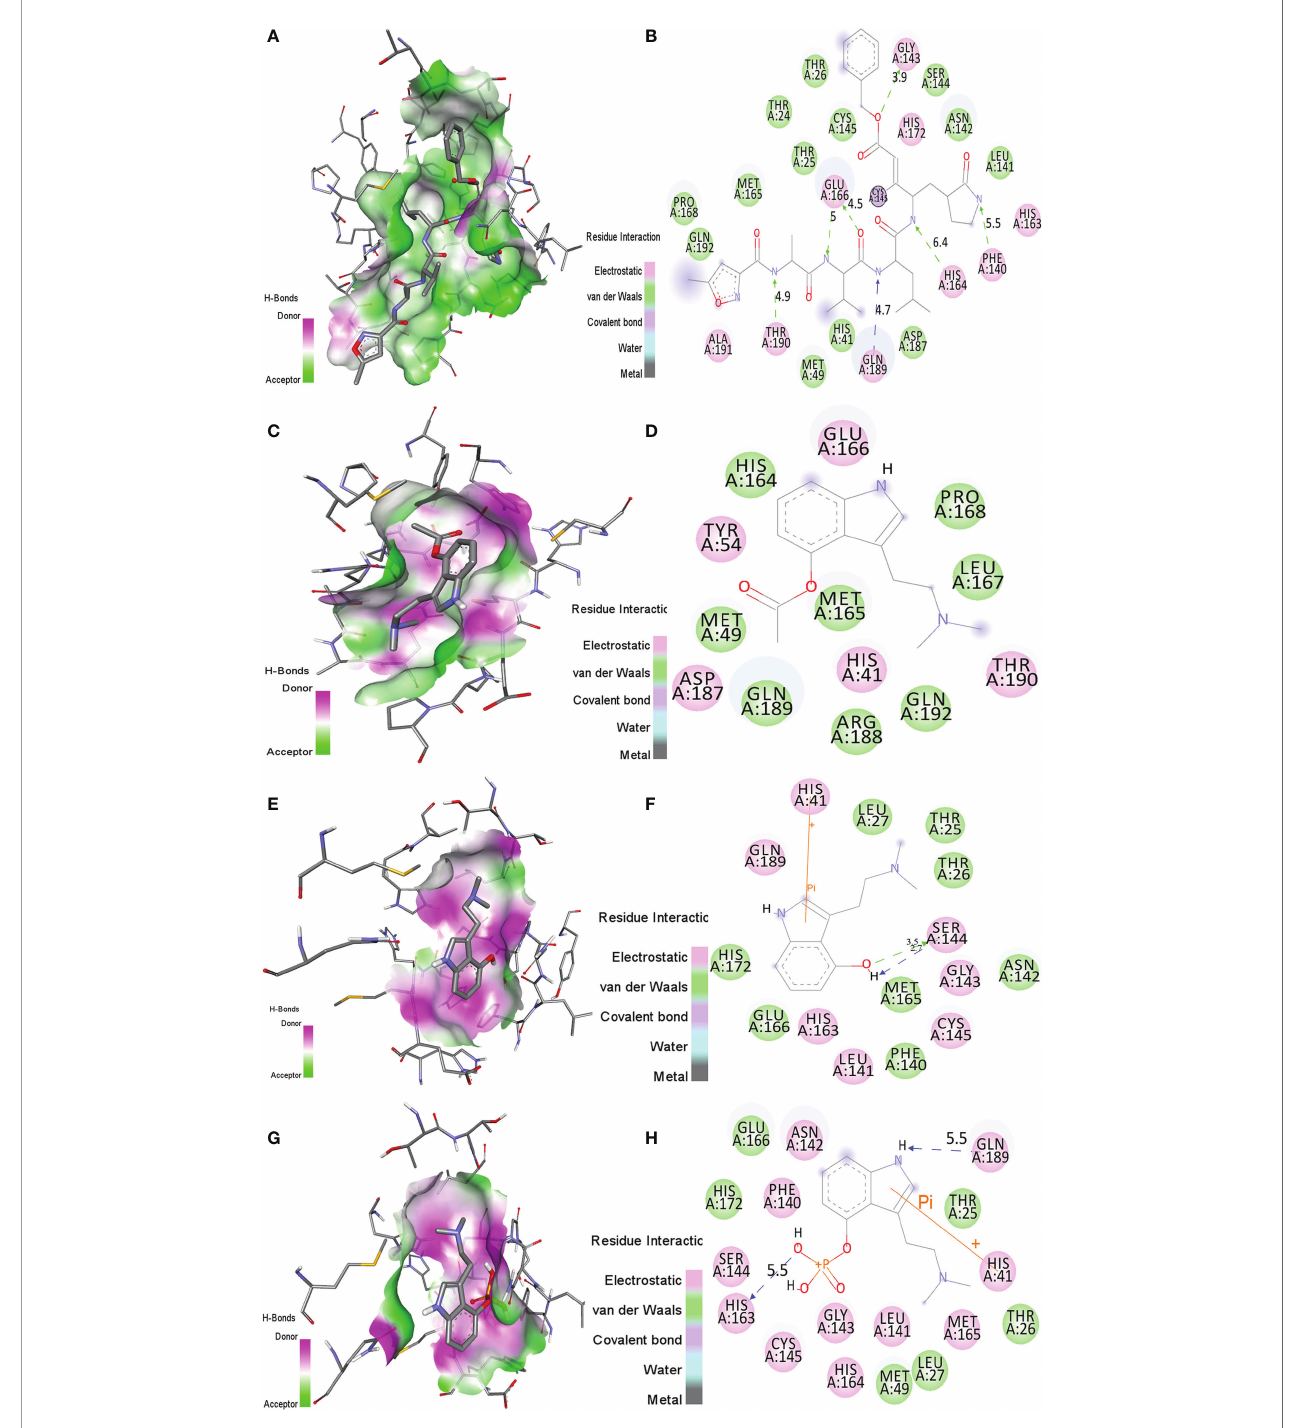
FIGURE 1 | The molecular interactions of (A, B) N3 inhibitor, (C, D) psilacetin, (E, F) psilocin, and (G, H) psilocybine with the active pocket of SARS-CoV-2 Mprotease. The structure indicated different residual